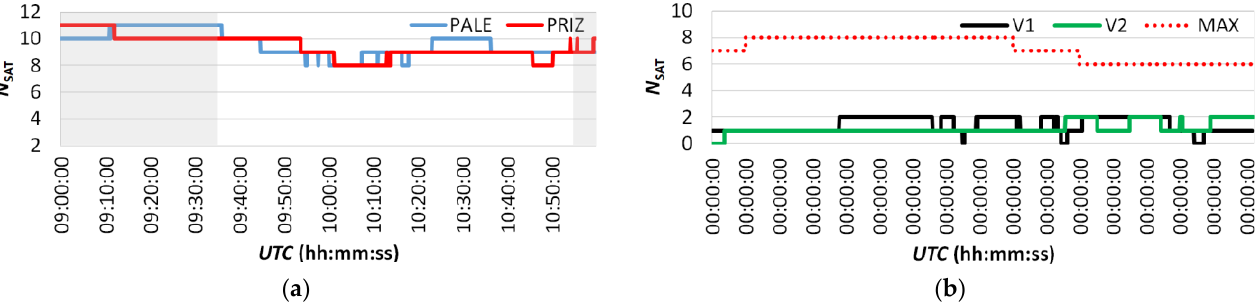
Figure 6. The number of GPS satellites: ( a ) CORS PALE and PRIZ (blue and green lines, respectively); ( b ) V1 and V2 (black and green lines, respectively). Non-overlapping periods between the permanent stations and the landmarks acquisitions are shaded in grey. The maximum number of satellites for the given position, measurement period, and elevation cut-off (dashed red line).